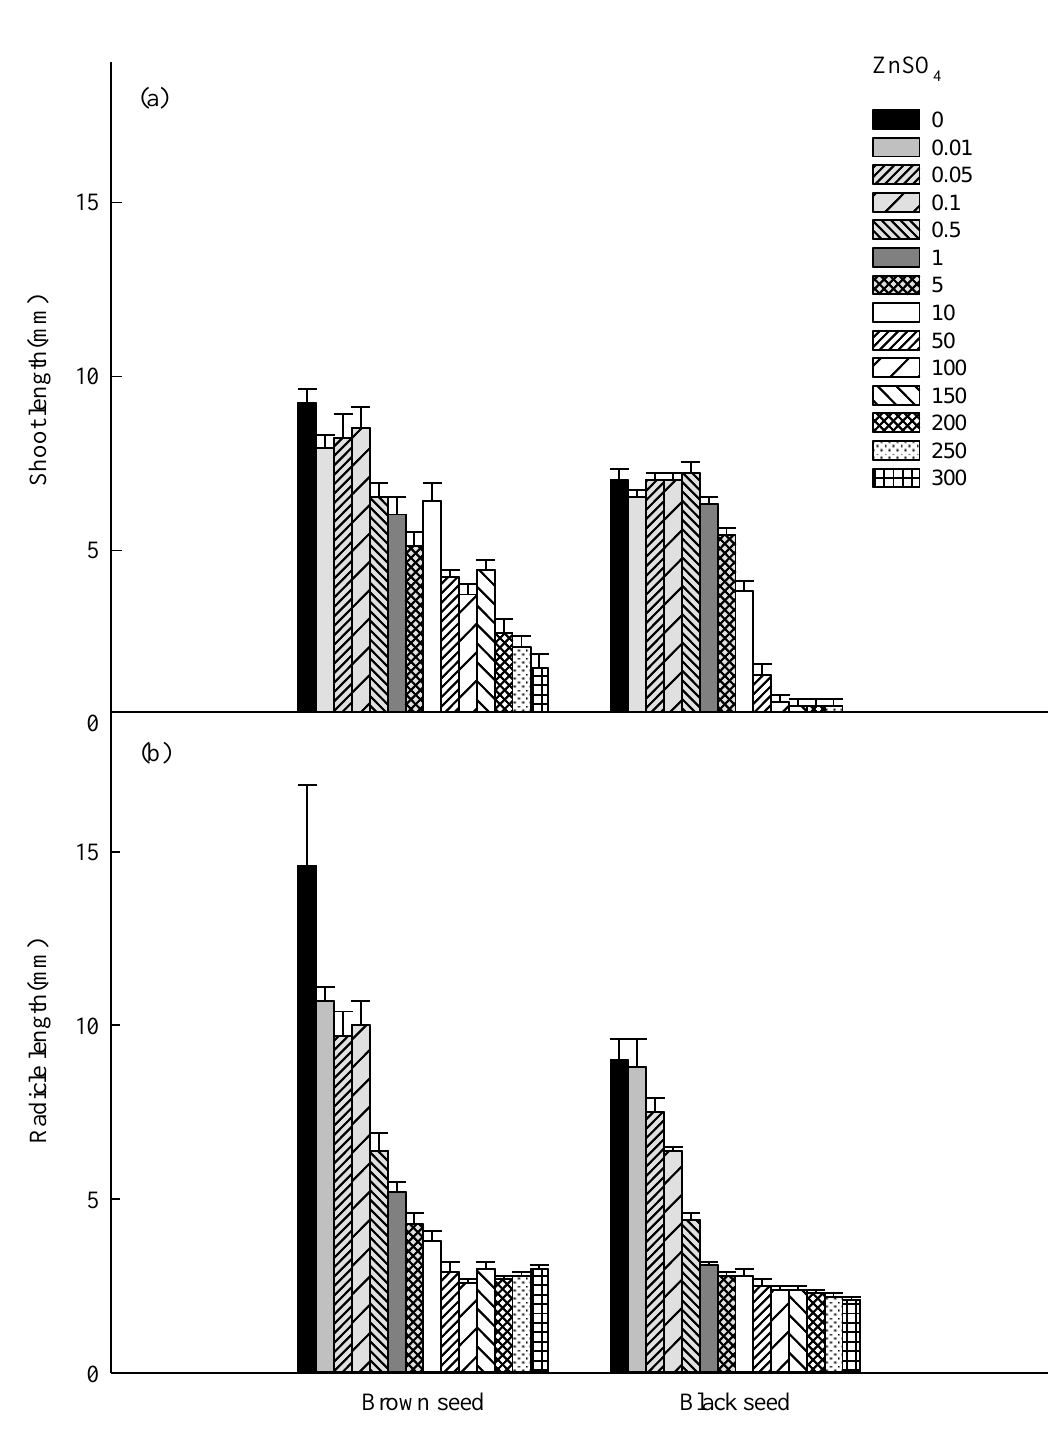
Figure 2. Effect of Zn on ( a ) shoot and ( b ) radicle length of seedlings grown from dimorphic seeds of S. salsa.